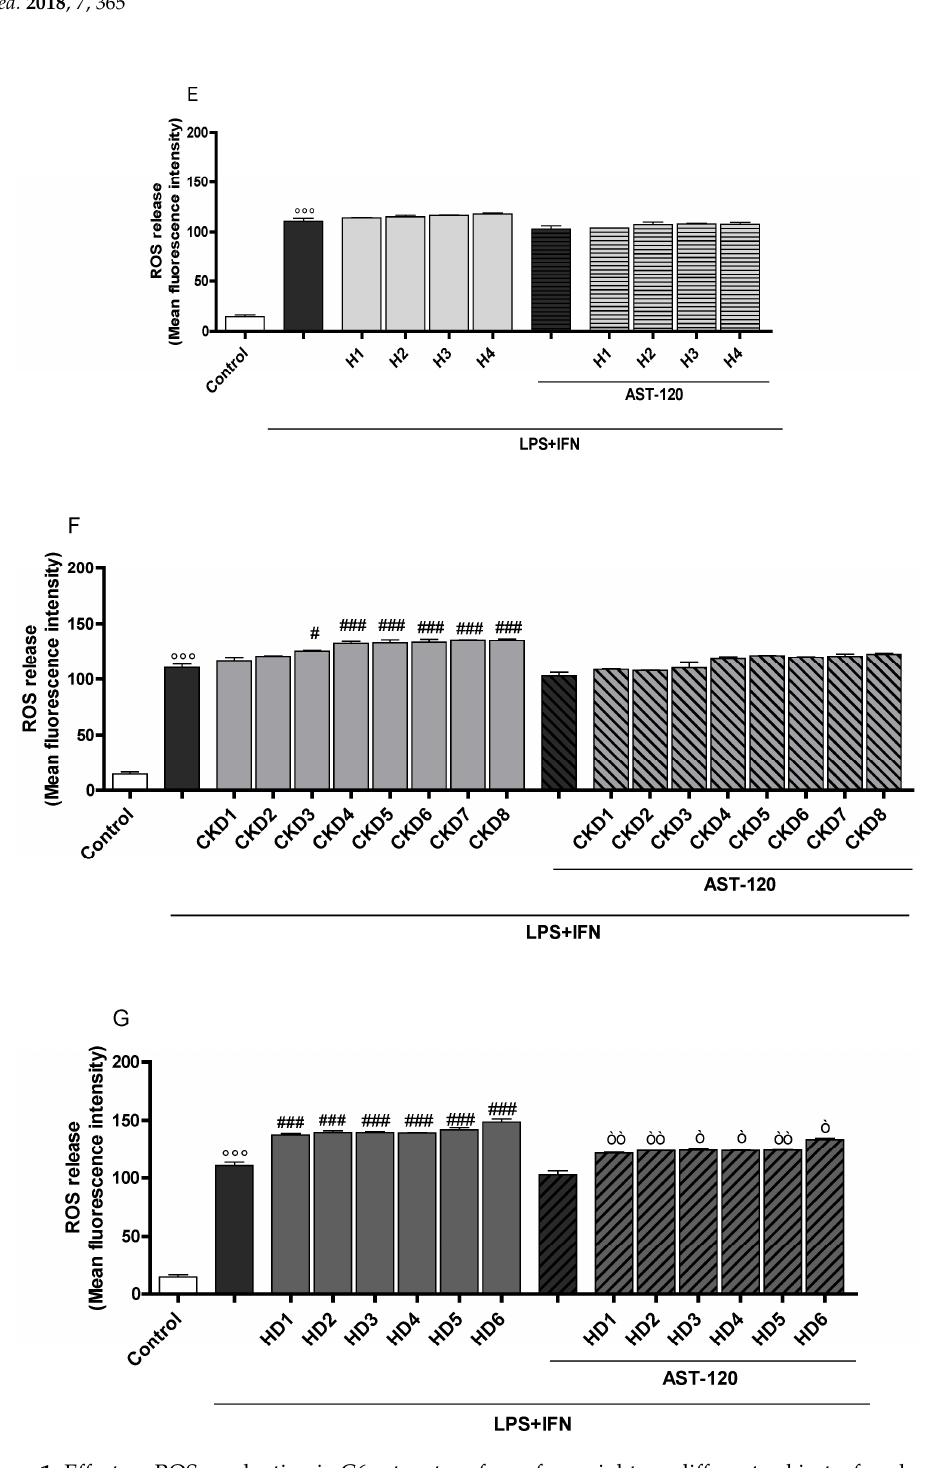
Figure 1. Effect on ROS production in C6 astocytes of sera from eighteen different subjects: four human healthy people (H1–H4; Panel A ), eight CKD patients (CKD1–CKD8; Panel B ), and six CKD dialysed patients (HD1–HD6; Panel C ), also treated with AST-120. In order to highlight the relationship between ROS release and IS serum levels, a linear regression analysis was performed. Linear regression of ROS release by C6 cells treated with sera alone or in the presence of AST-120, indicated F = 52.65, DFn = 1, DFd = 68, p < 0.0001; the difference between the slopes are considered extremely significant ( Panel D ). The effect of the eighteen tested sera, also treated with AST-120, on ROS production in C6 astrocytes during inflammatory conditions, induced by LPS (1 µ g/mL) + IFN (100 U/mL) is shown ( Panel E , F , and G ). Comparisons were performed using a one-way analysis of variance and multiple comparisons were made by Bonferroni’s test. ◦◦◦ , ◦◦ and ◦ denote p < 0.001, p < 0.05 vs. control. ***, ** denote p < 0.001, p < 0.01 vs. serum alone. ###,# denote p < 0.001, p < 0.05 vs. LPS + IFN. òò , ò denote p < 0.01, p < 0.05 vs. serum + LPS + IFN.